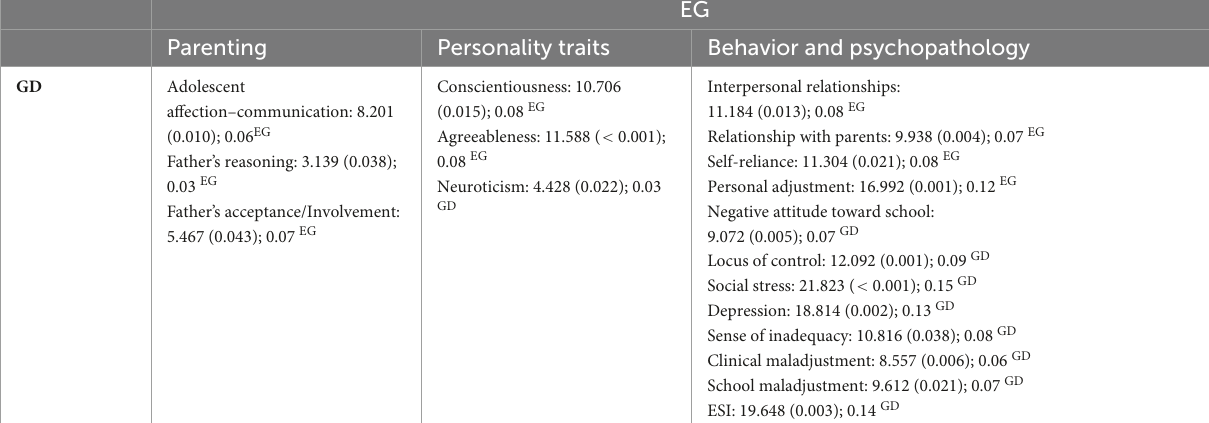
TABLE 5 Differences between Excessive Gaming and Gaming Disorder according to ANOVA analysis ( F [ p ]); ES.